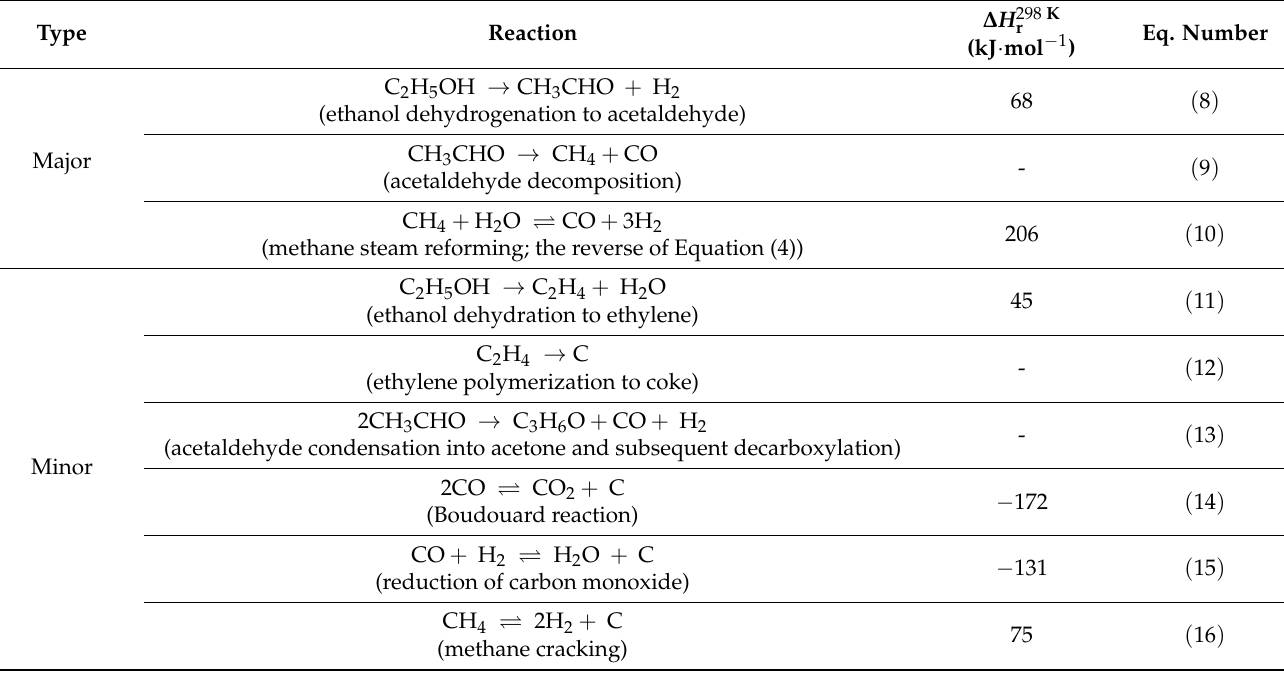
Table 3. Reaction routes considered for the ESR in Figure 7.